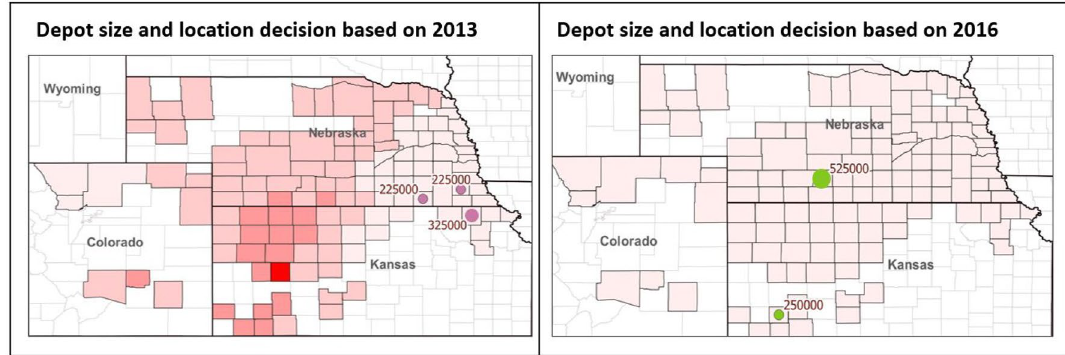
Figure 5. Depot location based on 2013 and 2016’s weather information with drought index map.